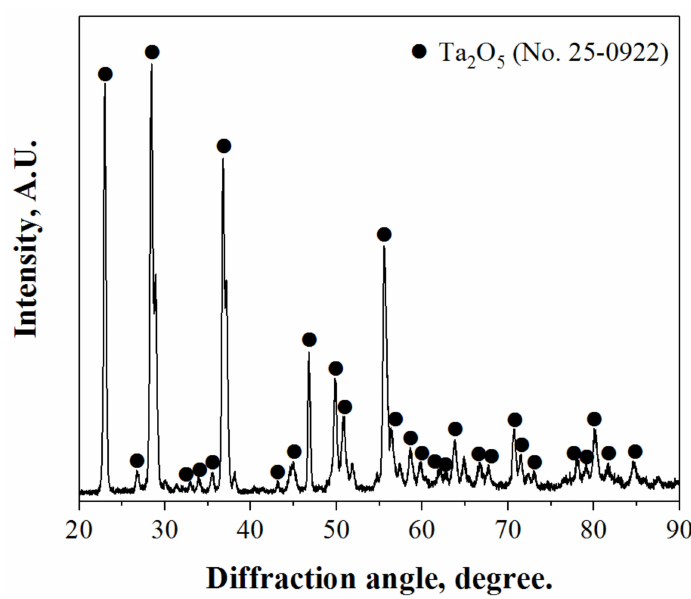
Figure 2. SEM microstructure of raw Ta 2 O 5 powder.